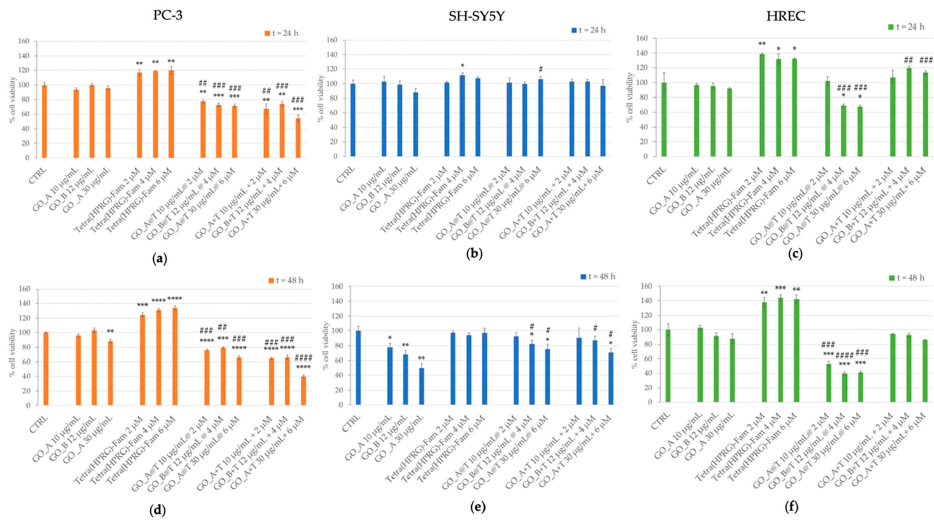
Figure 5. Cell viability from MTT assays of prostate cancer ( a , d ), neuroblastoma ( b , e ) and endothelial ( c , f ) cells incubated for 24 h ( a – c ) or 48 h ( d – f ) with the hybrid GO@T samples at increasing